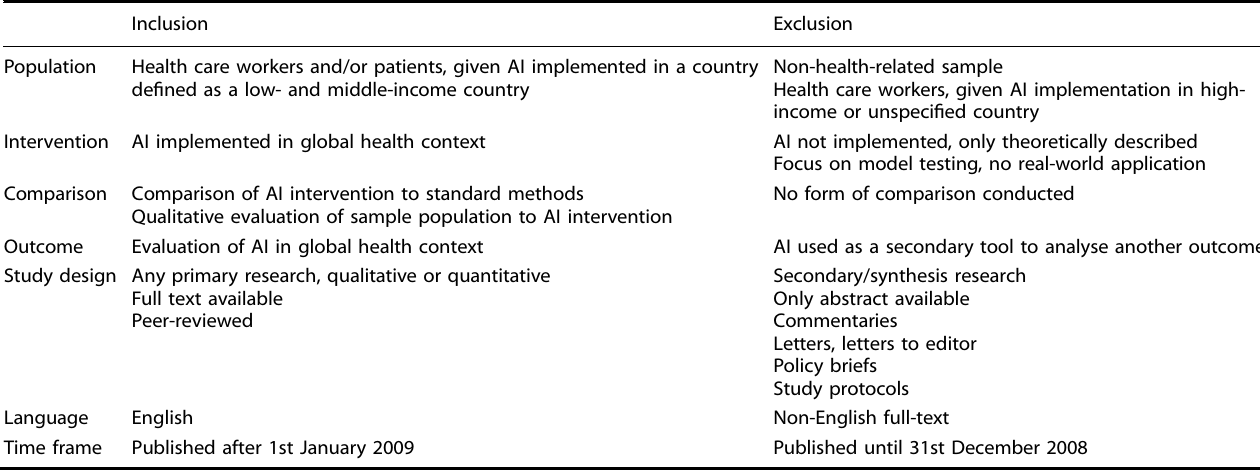
Table 6. Inclusion and exclusion criteria based on the PICOS (population, intervention, comparison, outcome and study design) framework.